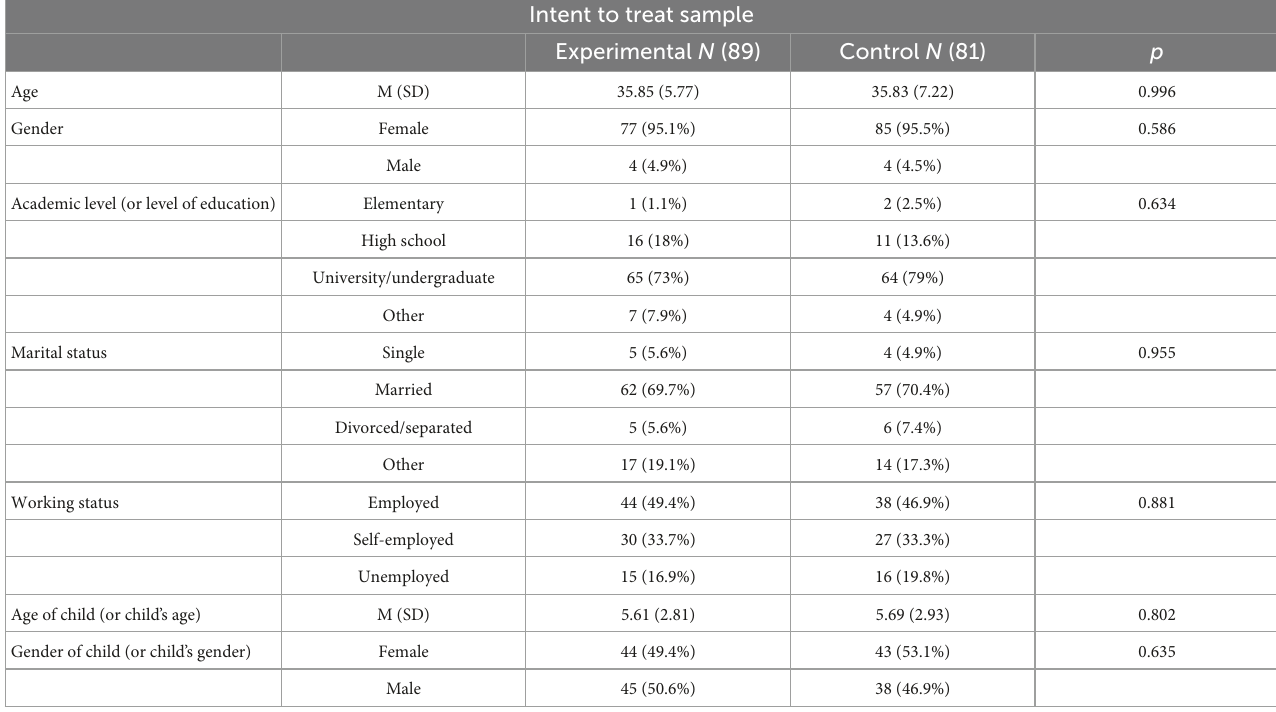
TABLE 1 Sociodemographics characteristics of participants in the initial sample, depending on group assigned: experimental group or control group.